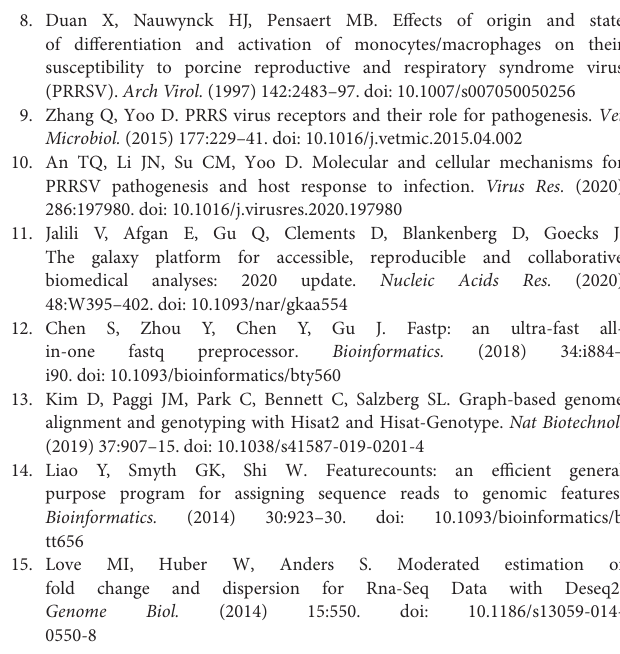
Supplementary Table 1 | MLV-129p-IFNmix differentially expressed gene list. Supplementary Table 2 | MLV-ATP differentially expressed gene